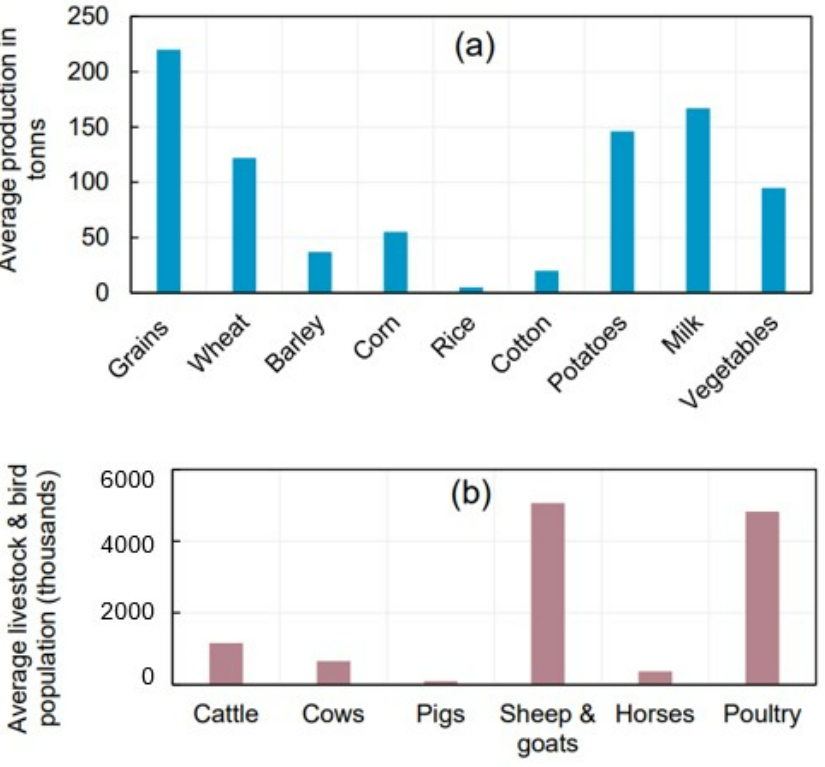
Figure 6. ( a ) average